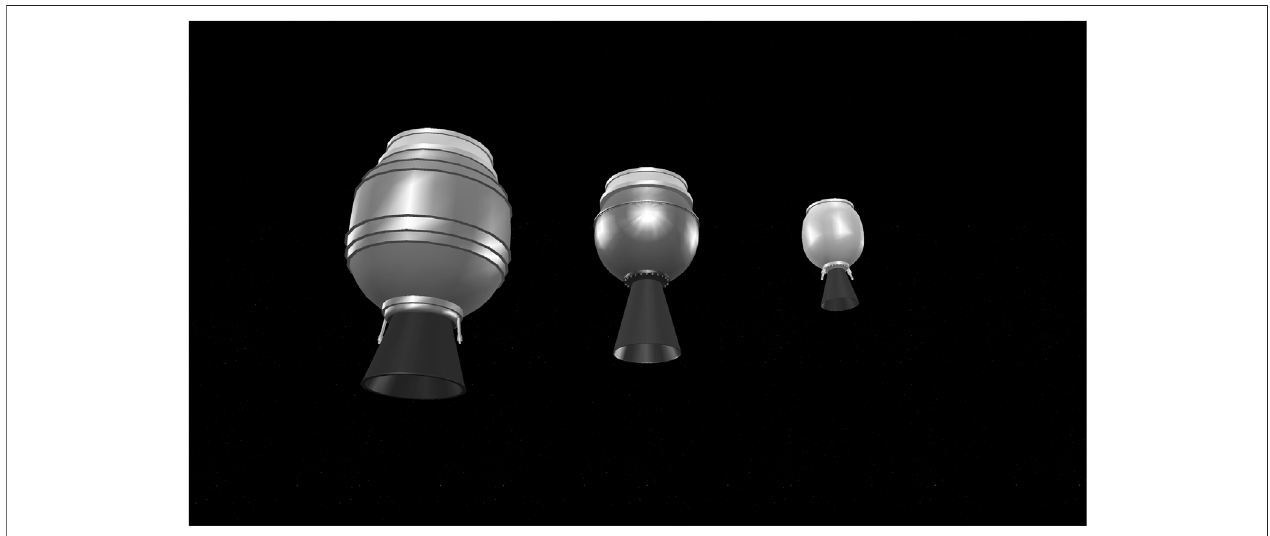
FIGURE 5 | The three upper stages models used in the V-REP simulation. From left to-right: STAR-48b, STAR-24c, and STAR-13b, all manufactured by Orbital ATK. The models have been designed according to the dimensions and mass parameters provided by the manufacturer [Orbital ATK Inc. (2018)].